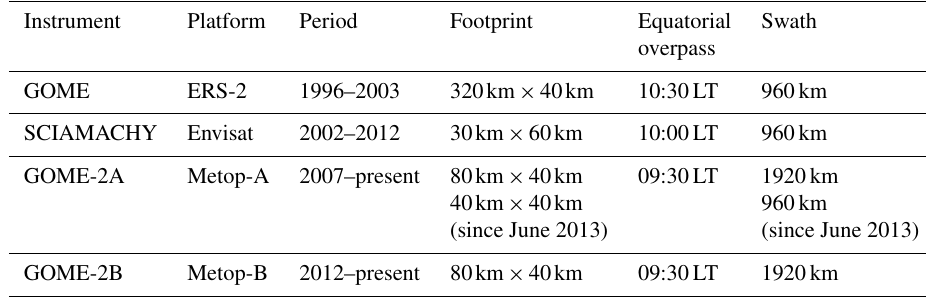
Table 1. Attributes of the satellite instruments used in this study. Instrument Platform Period Footprint Equatorial Swath